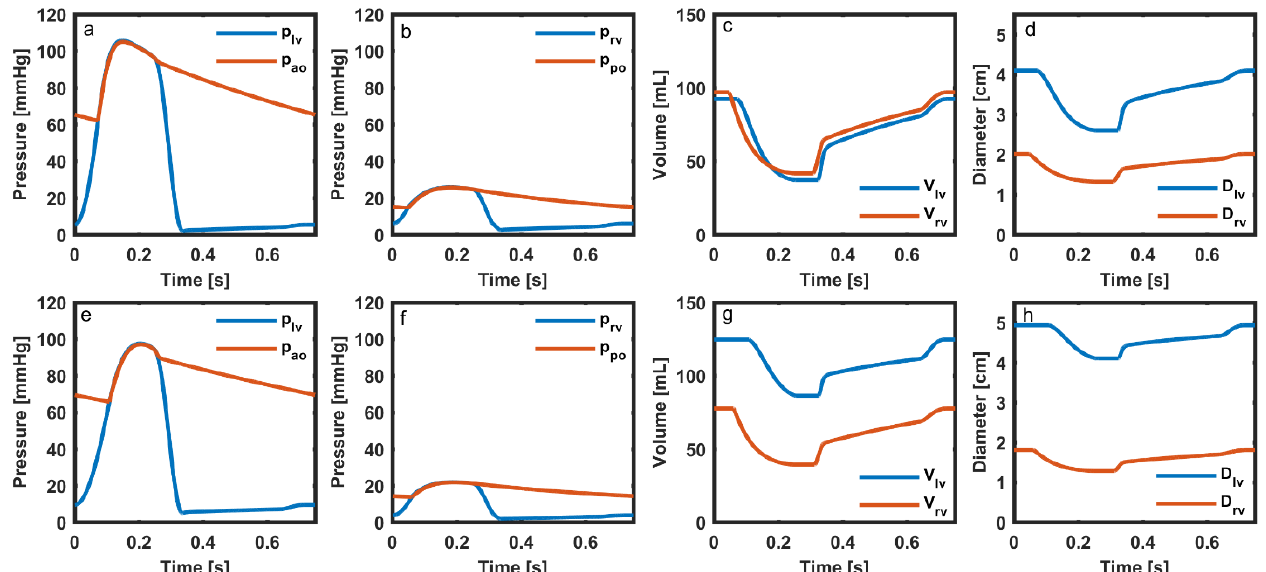
Figure 2. ( a ) Left-ventricular and aortic pressures, ( b ) right-ventricular and pulmonary arterial pressures, ( c ) left and right-ventricular volumes, ( d ) left and right-ventricular diameters in the healthy cardiovascular system model, ( e ) left-ventricular and aortic pressures, ( f ) right-ventricular and pulmonary arterial pressures, ( g ) left and right-ventricular volumes, ( h ) left and right-ventricular diameters in the DCM cardiovascular system model. p, pressure; V, volume; D, diameter; lv, left ventricle; ao, aorta; rv, right ventricle, po, pulmonary artery. Left-ventricular and aortic peak pressures reduced slightly in the DCM cardiovascular system model. Right-ventricular and pulmonary arterial pressures were similar in the healthy and DCM cardiovascular system models. Right-ventricular volume was slightly higher in the DCM cardiovascular model than the left-ventricular volume in the healthy cardiovascular system model, whereas left-ventricular volume as well as left-ventricular diameter increased remarkably in the DCM cardiovascular system model. Aortic pressure, left-ventricular volume and diameter under HVAD, HM2 and HM3 support are shown in Figure